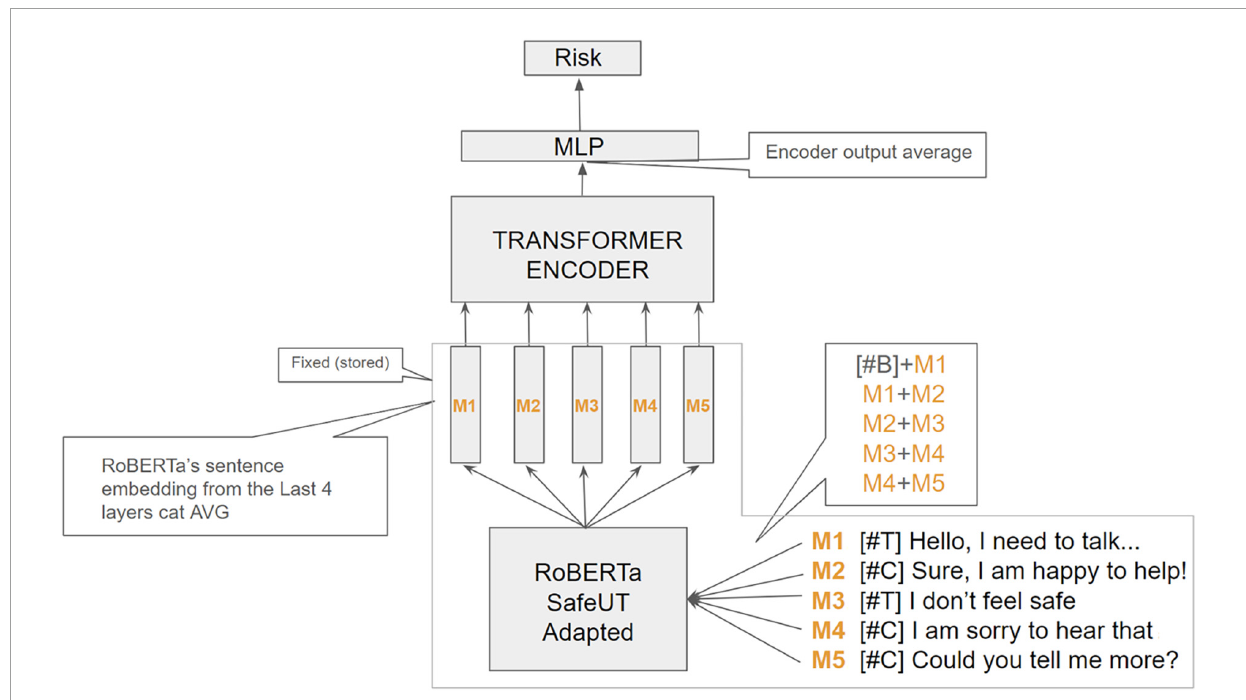
FIGURE1 Architecture of the neural network model using an example of five messages. B, beginning token; C, client, M, message; MLP, Multiple-layer perception; T, therapist. Example using a 5-message encounter input. Special tokens (#T) and (#C) are prepared to each client and counselor message, respectively, to inform the model about the originator of each message along the conversation. We preprocessed each encounter by obtaining the aggregated RoBERTa sentence embeddings of every pair of consecutive message-spans in the encounter. Each obtained sentence embedding sequence is passed through a transformer-encoder block, whose output is aggregated to obtain an encounter embedding representation. The encounter vector is then fed to a final neural linear layer to obtain the binary confidence estimates for